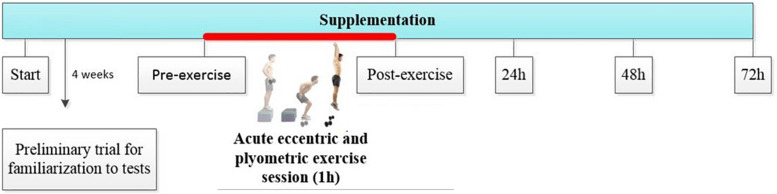
Study design and intervention scheme. Pre–Post: times before and after 1 h acute eccentric and plyometric exercise intervention. Post24, Post48, and Post72: evolution and behavior of variables during the 24, 48, and 72 h of recovery.